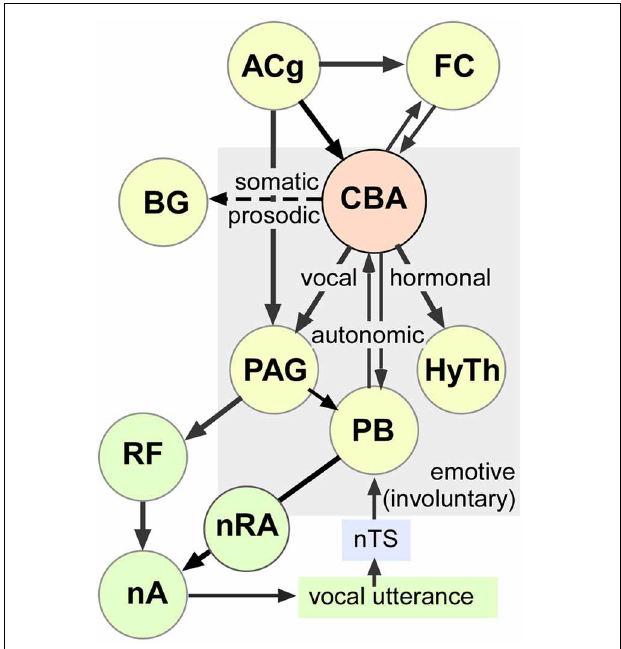
FIGURE 8 | Schematic-representation of an amygdala-centric control of emotive vocalizations within multimodal outputs. This working model is based on studies of others as well as our observations of stimulation-induced vocal, autonomic, and somatic activity mediated by neuronal clusters in the central and basal amygdala in mustached bats. Long term hormonal changes (not measured here) are presumably mediated by the hypothalamus. The exact path by which each effect is mediated is less clear and could involve descending projections as well as higher-order loops through the cortex. Dashed arrow represents putative projection (evidence for specific projections and effects on prosody and pinna movements is lacking) to the basal ganglia, which also projects to the ACg via the thalamus. The schematic includes information from multiple sources (see text for details). AC, Auditory Cortex; ACg, Anterior Cingulate; BG, Basal Ganglia; FC, Frontal Cortex; CBA, Centrobasal Amygdala; HyTh, Hypothalamus; nA, nucleus Ambiguus; nRA, nucleus Retroambiguus; nTS, nucleus of the Solitary Tract; PAG, Periaquedectal Gray; PB, Parabrachium; RF, Reticular